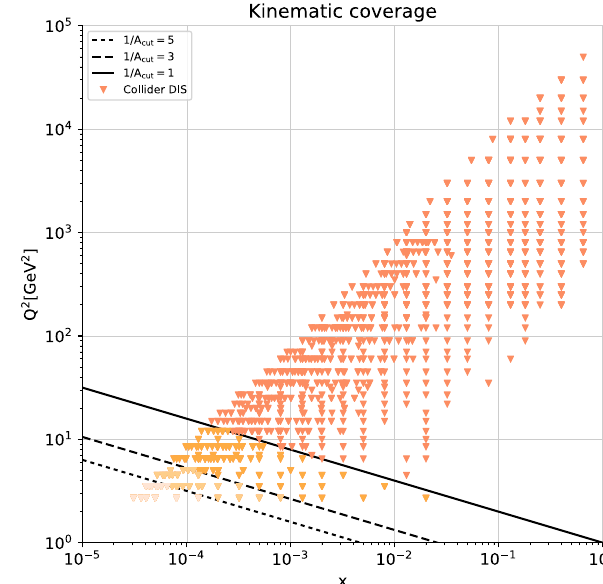
Fig. 23 ThekinematiccoverageoftheHERAinclusivestructurefunc- tion data that enters the NNPDF3.1sx fits. The tilted lines represent rep- resentative values of the cut to DIS data applied after the fit to study evi- dence for BFKL effects at small x and small Q 2 . Left plot: perturbative-